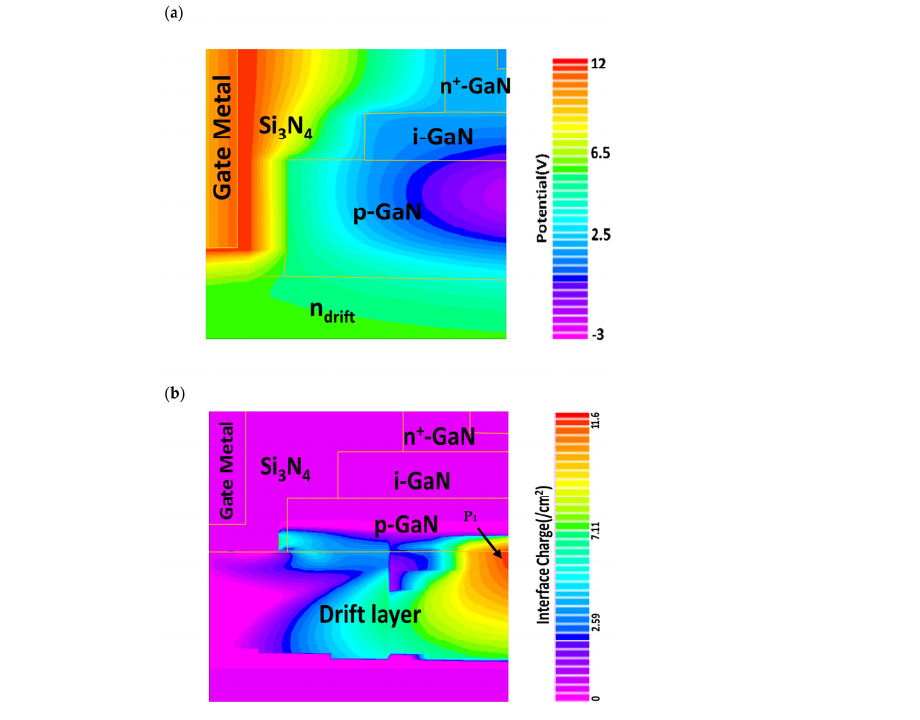
Figure 4. ( a ) Variation of channel potential of the staircase channel transistor.; ( b ) Generation rate of charge carriers by impact ionization.